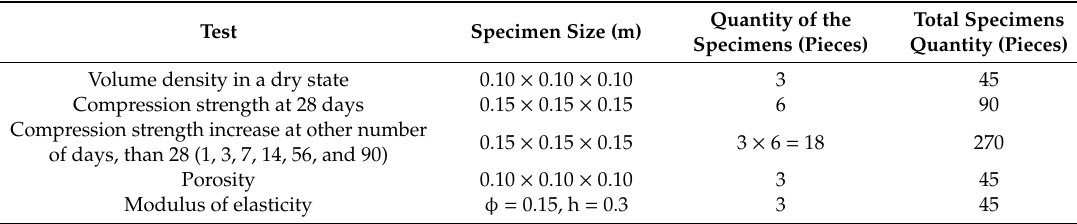
Table 6. The summary of the size and quantity of the specimens for testing.